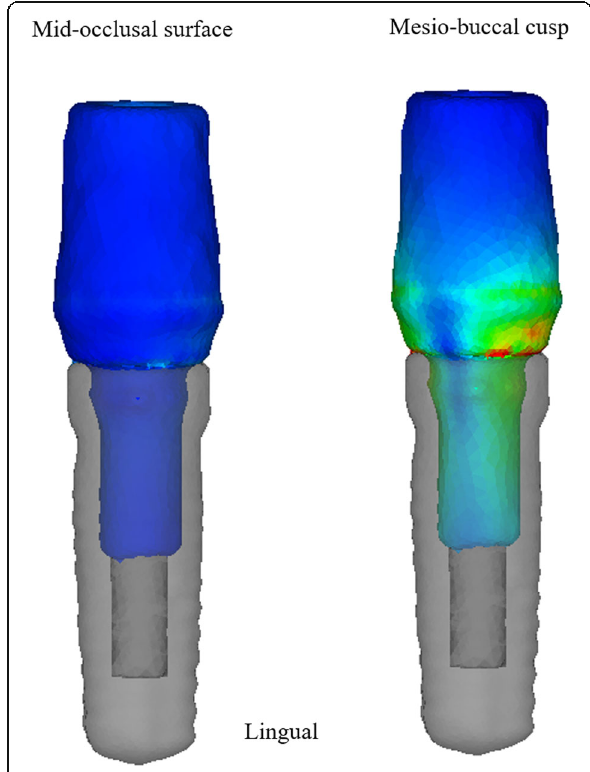
Fig. 14 Distribution of the stress in the abutments of VM/HM under 90° loading at the mid-occlusal surface and the mesiobuccal